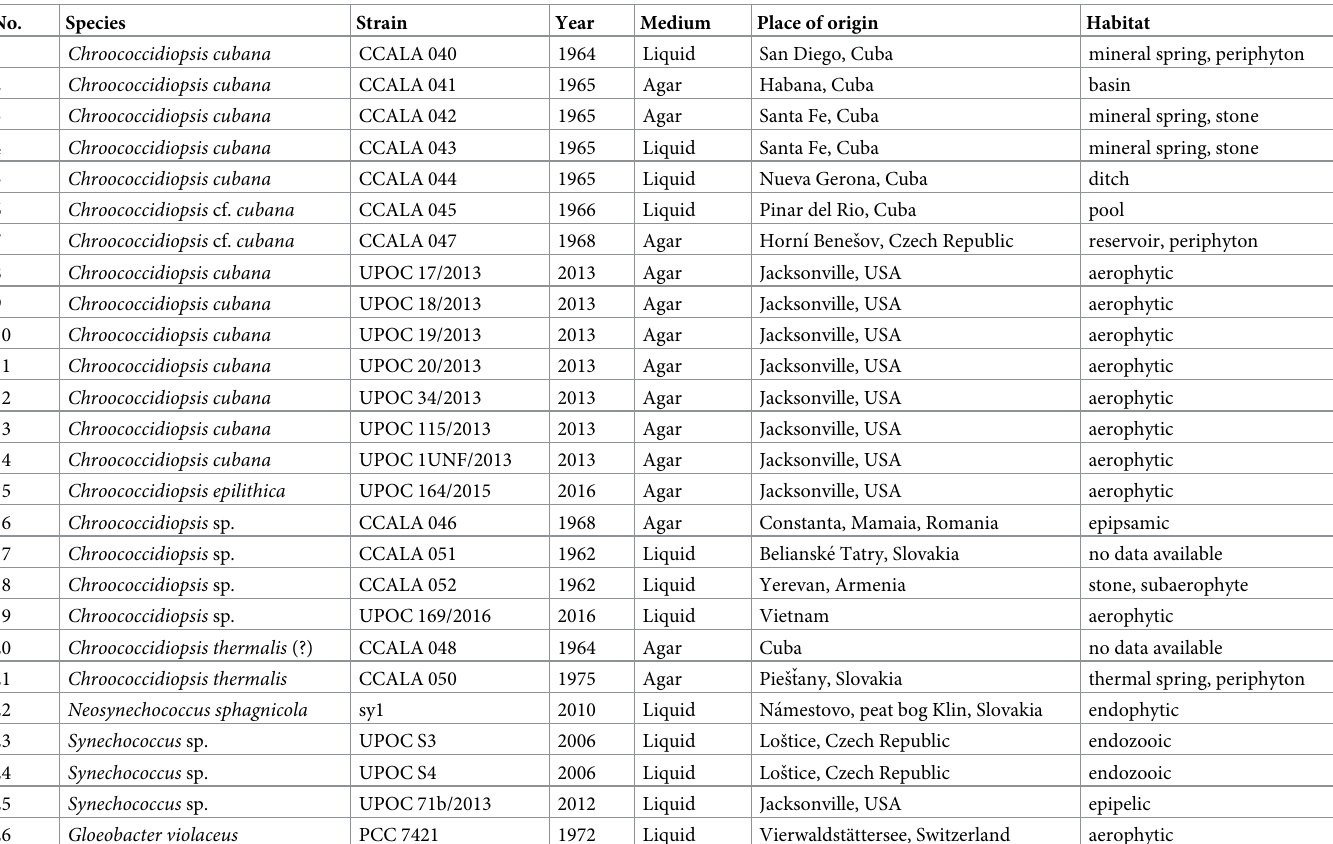
Table 1. A group of cyanobacteria samples analyzed in this work.